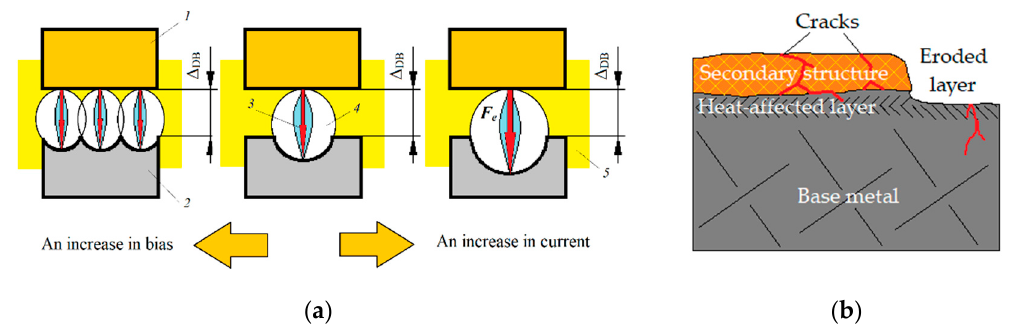
Figure 13. Electrical discharge machining principles: ( a ) dependencies of the discharge pulse character on bias and current, where ( 1 ) is a tool electrode, ( 2 ) is a workpiece, ( 3 ) is a discharge channel, ( 4 ) is a plasma cloud, ( 5 ) is dielectric medium, and F e is discharge force; ( b ) submicron structure of erosion wear.